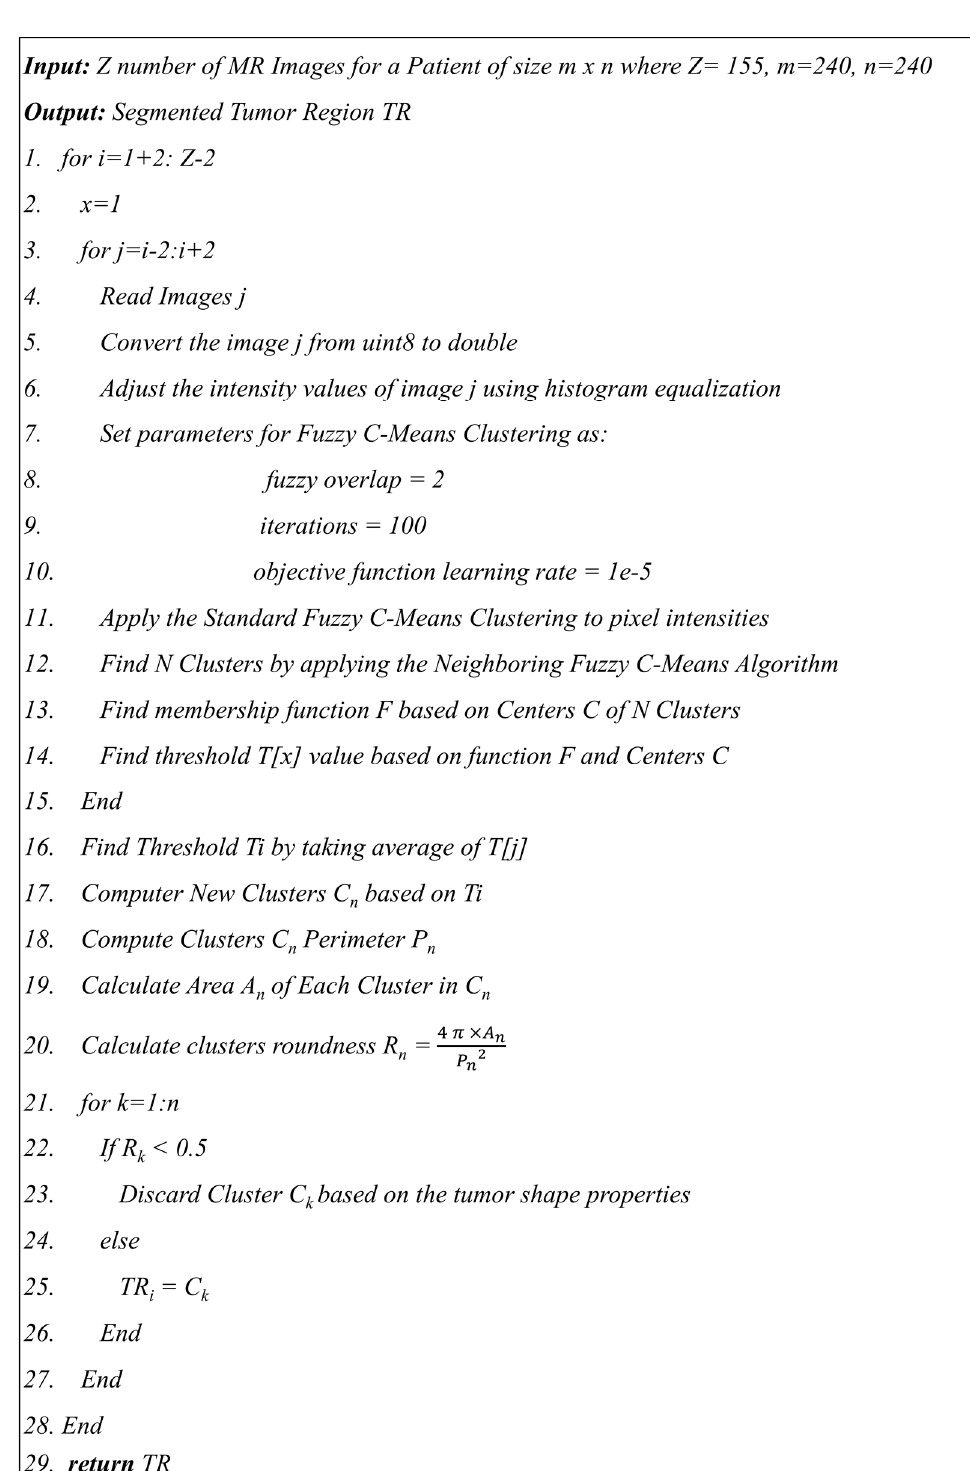
Figure 9. Proposed Algorithm 1 for tumor segmentation using Neighboring FCM.